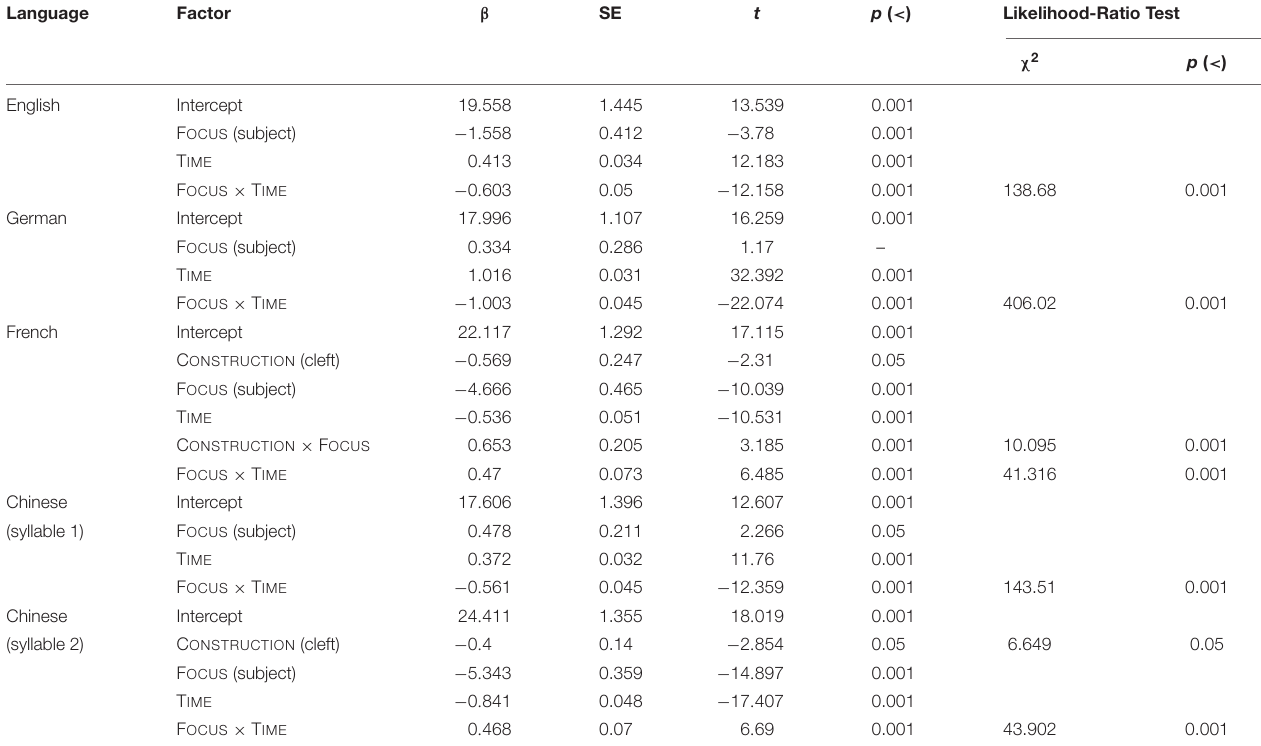
TABLE 2 | Linear fixed-effects models of best fit on the f o measurements (semitones): object. Language